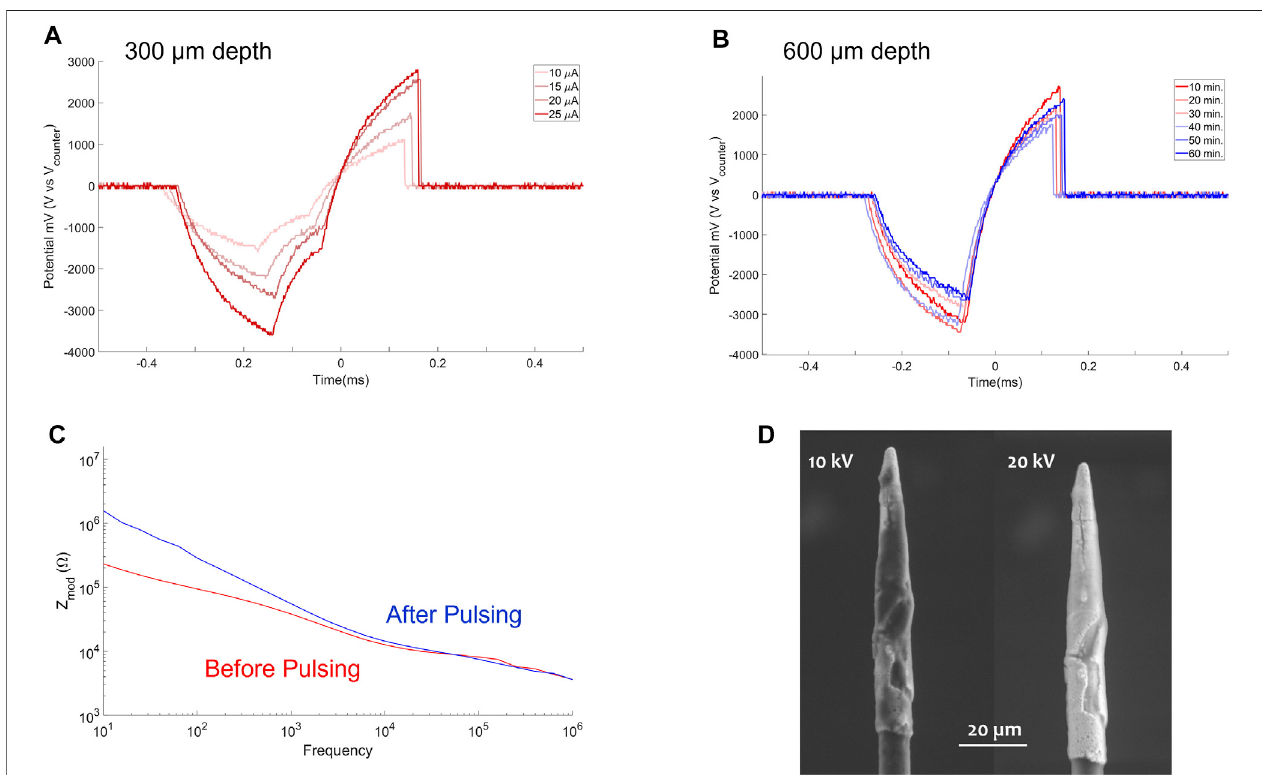
FIGURE 8 | In vivo pulsing tests. (A) VT recorded in rat visual cortex at depth of 300 μ m, 6,000 cathodic fi rst biphasic pulses of 200 μ s duration, 100 μ s gap interphaseat50 Hzweredeliveredatfourdifferentcurrentamplitudes(10,15,20and25 μ A). (B) VT invivo pulsingtest(1 h)at600 μ mdepthrecordedevery10 min (C) PtIr-HDCFimpedancebefore(redsolidline)andafter(bluesolidline)the invivo pulsingtest. (D) SEMofthePtIr-HDCFafterthe invivo pulsingtestacquiredat10 kV (left) and 20 kV (right)